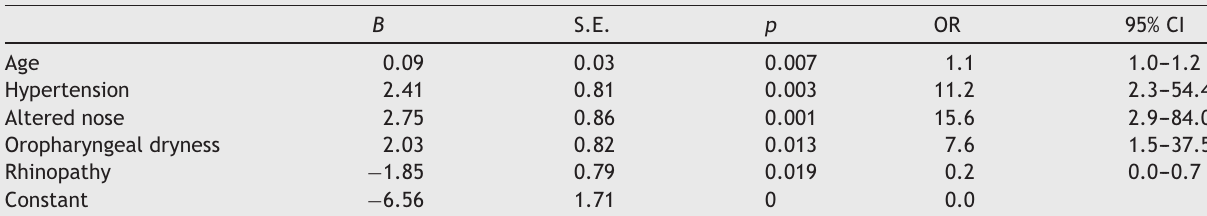
Logistic regression model of UARS